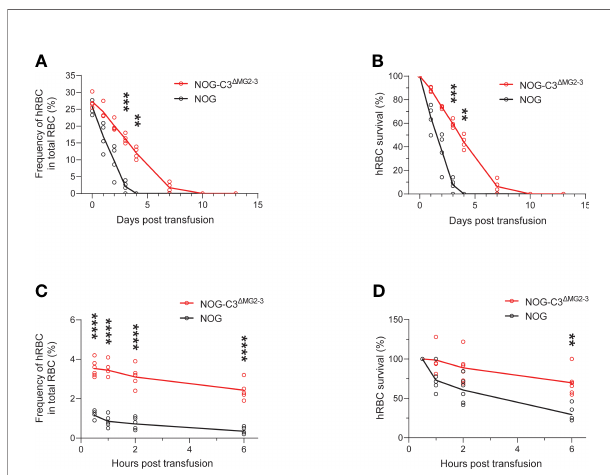
FIGURE 2 | Elimination of hRBCs in NOG and NOG-C3 D MG2-3 mice. (A, C) Changes in the frequencies of hRBCs relative to total RBCs over time. PB samples from NOG and NOG-C3 D MG2-3 mice were collected and analyzed at the indicated time points (same as in Figure 1 ). Each group (red line for NOG-C3 D MG2-3 and black line for NOG) consisted of four mice (A) or six mice (C) . The numbers of transfused hRBCs were 5.0 x 10 9 (A) and 2.5 x 10 8 (C) . (B, D) Survival rates of hRBCs. The values in (B, D) were calculated from (A, C) , respectively, as percentages relative to the value on day 0. Asterisks indicate statistically signi fi cant differences between NOG-C3 D MG2-3 and NOG mice as determined by two-way repeated-measures ANOVA (****p < 0.0001, ***p < 0.001 and **p <